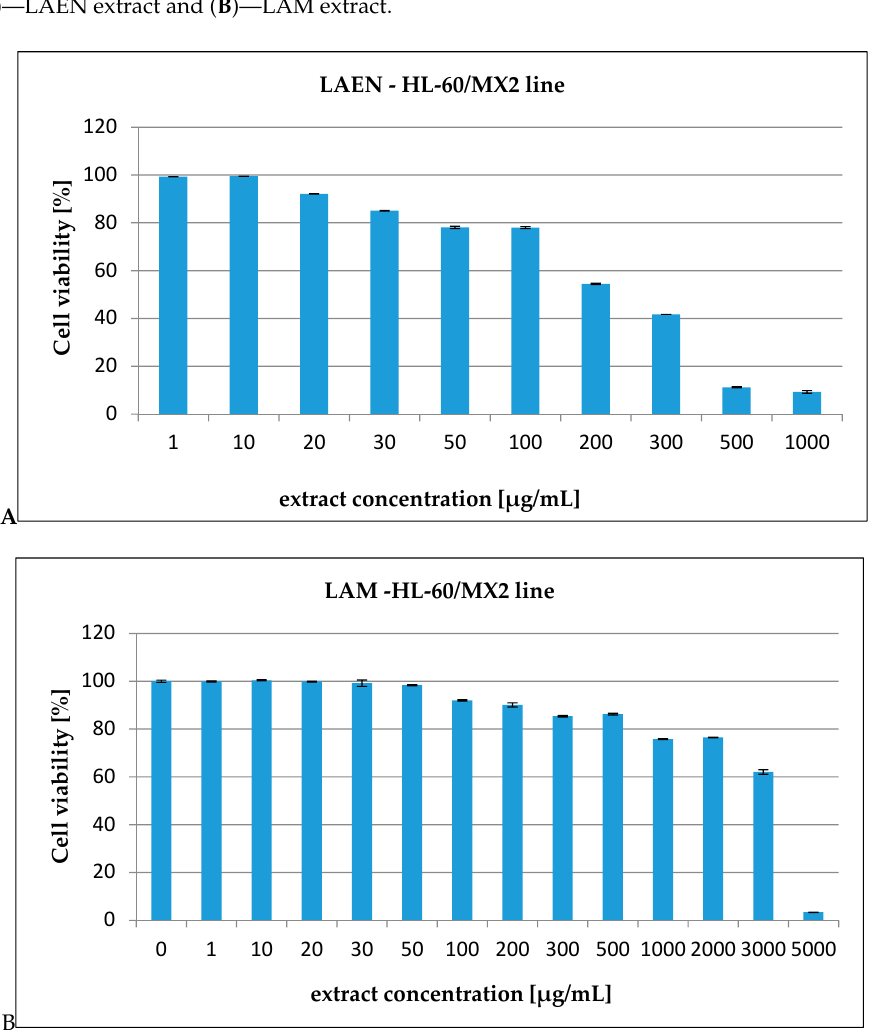
Figure 5. The valuation of the HL-60 / MX2 cell line viability exposed to 24 h of increasing concentrations of: ( A )—LAEN extract and ( B )—LAM